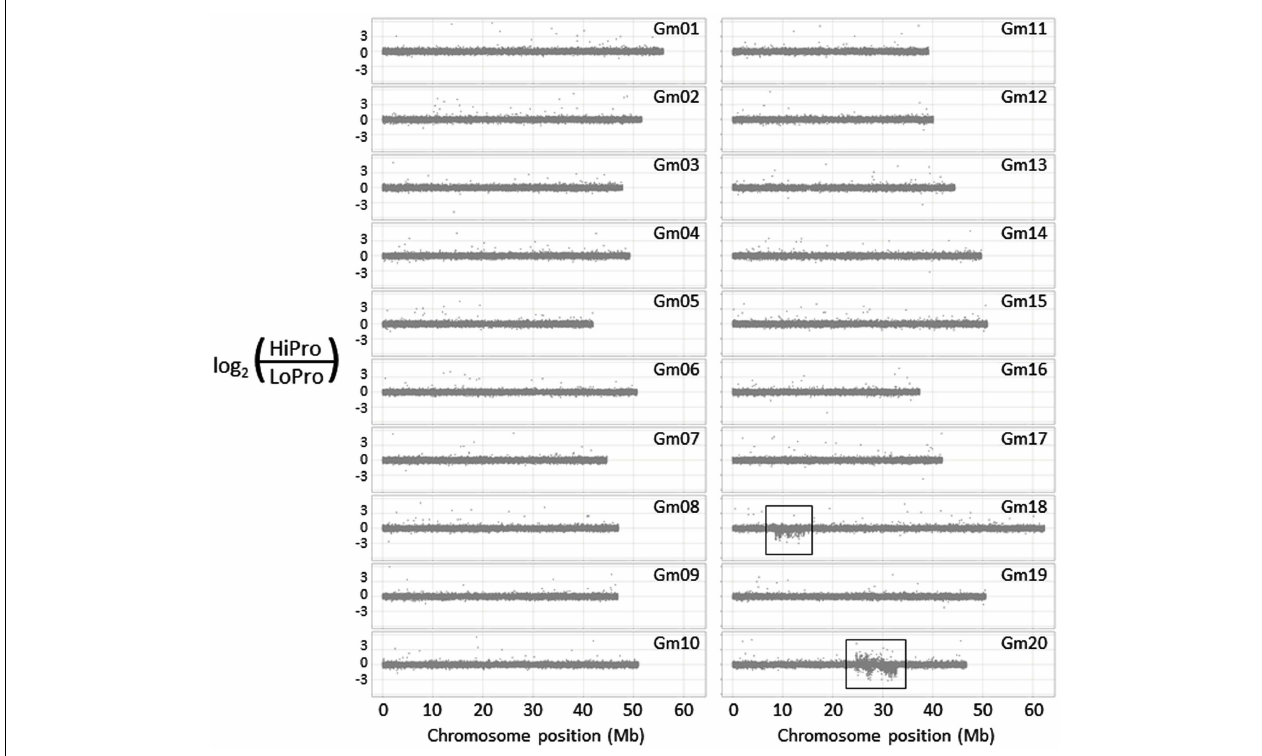
FIGURE 1 | Structural genomic analysis of the HiPro versus LoPro near isogenic lines. Two conspicuous polymorphic regions are visible on chromosomes 18 and 20 (boxed regions), corresponding to previously identified loci.